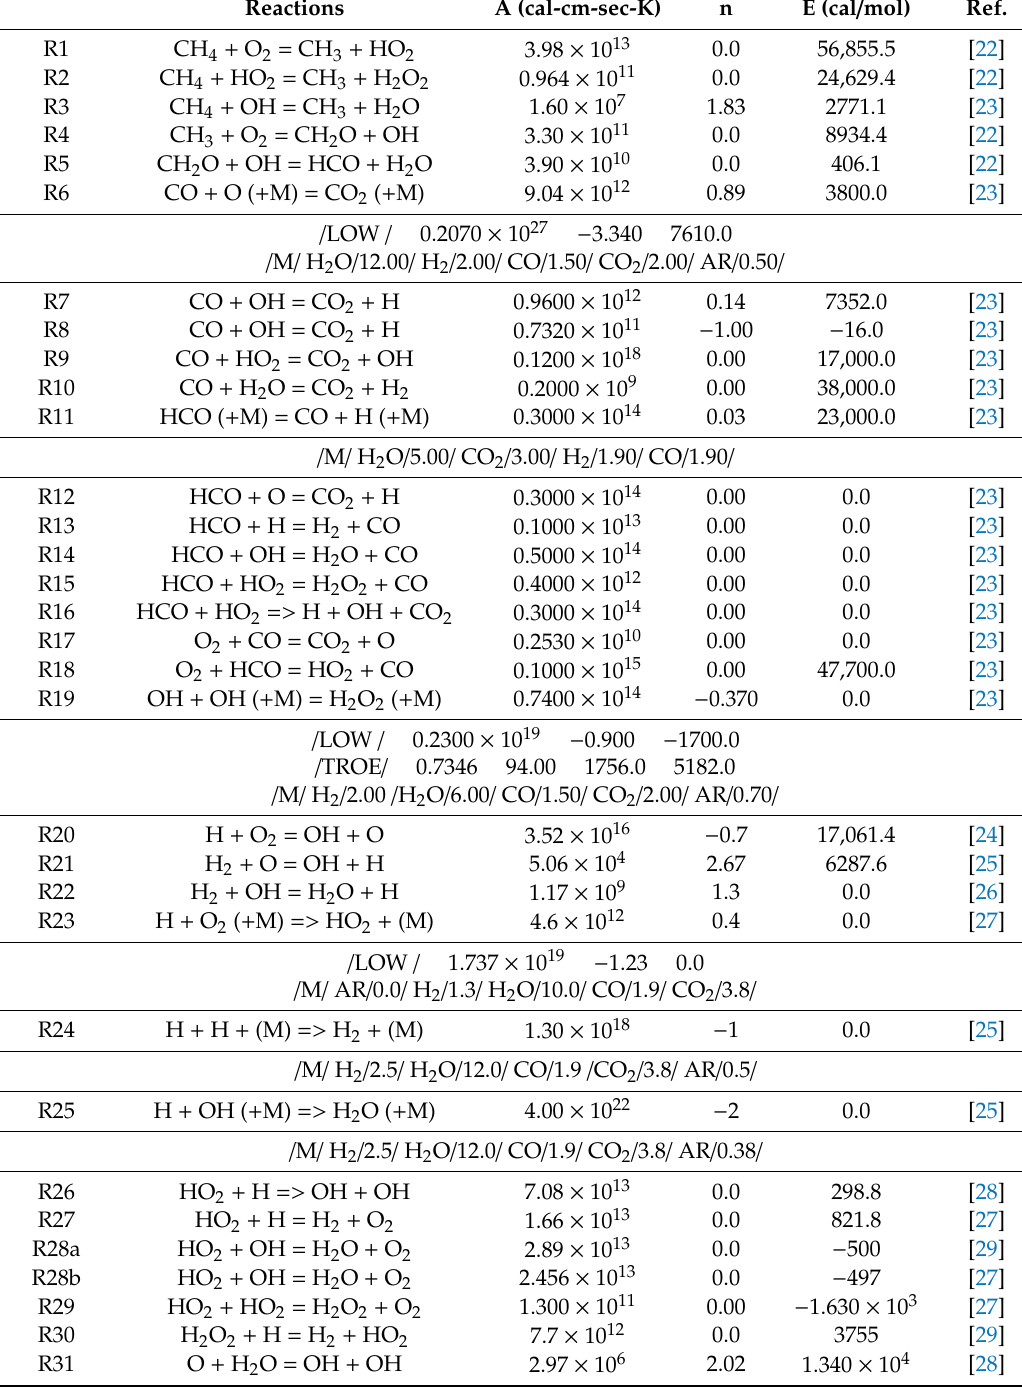
Table 1. Reduced chemical kinetics mechanism [19] used in this